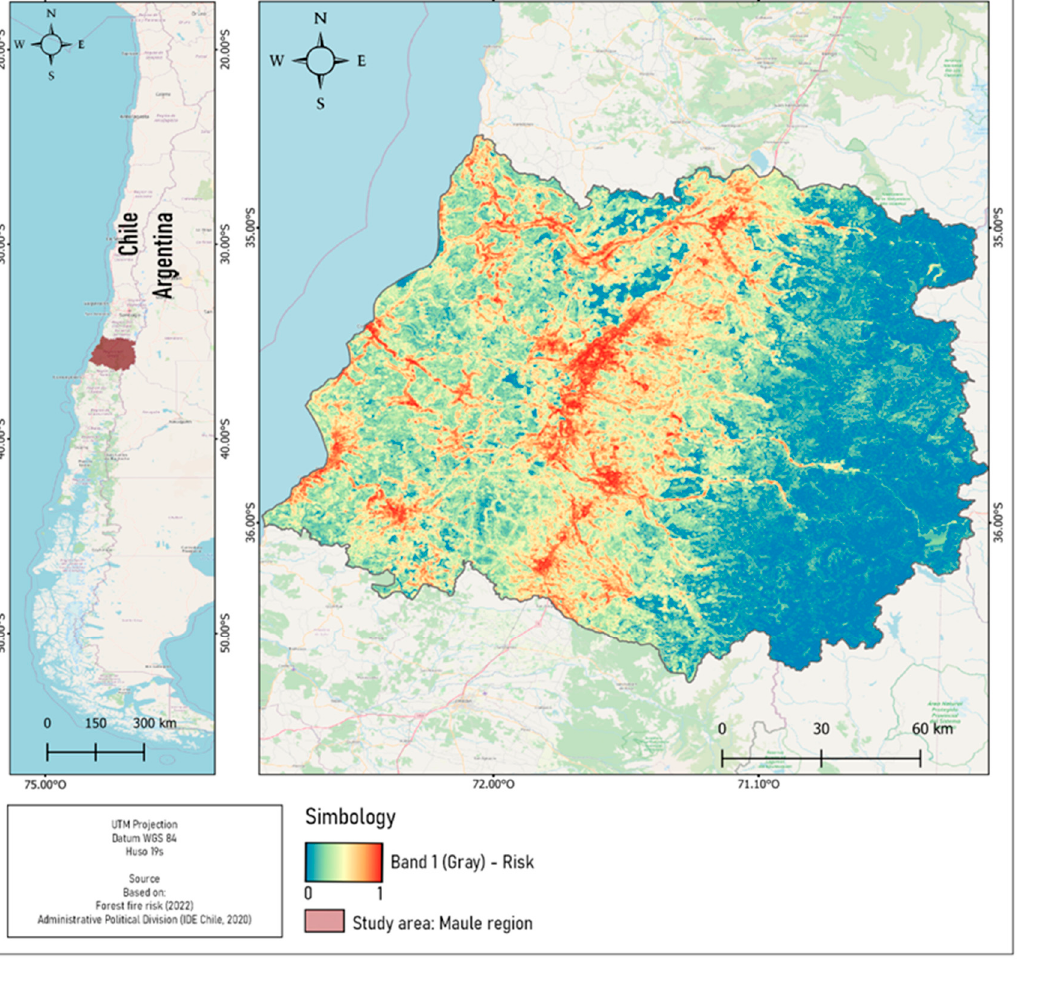
Figure 6. Ignition risk map in the Maule region, Chile.